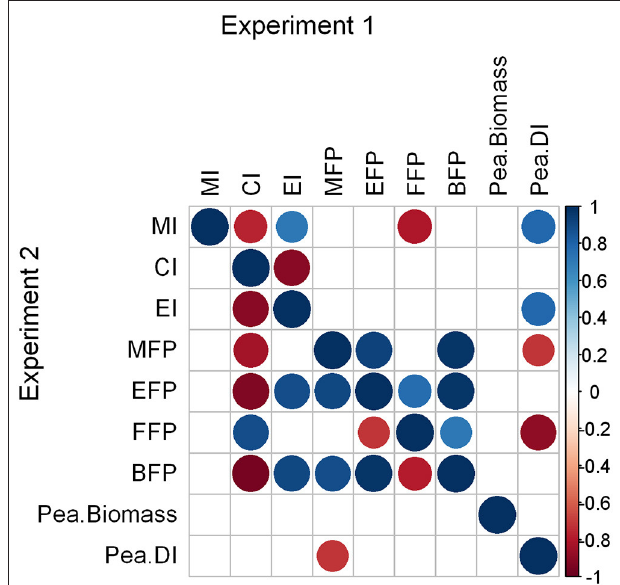
FIGURE 4 | Spearman’s rho correlation coefficients of nematode based bioindicators as well as pea biomass and disease indices independent of applied treatments. Correlations within experiments 1 and 2 are shown in the upper and lower diagonal, respectively. Positive correlations are displayed in blue and negative correlations in red color. Color intensity and the size of the circle are proportional to the correlation coefficients. In the right side of the correlogram, the legend color shows the correlation coefficients and the corresponding colors. Correlations with p -values > 0.05 ( n = 8) are considered insignificant and were left blank. Abbreviations: maturity index (MI), channel index (CI), enrichment index (EI), metabolic footprint (MFP), enrichment footprint (EFP), fungivore footprint (FFP), bacterivore footprint (BFP), pea dry matter yield (Pea.Biomass) and disease index of peas (Pea.DI). The latter two indicators were assessed in a separate greenhouse